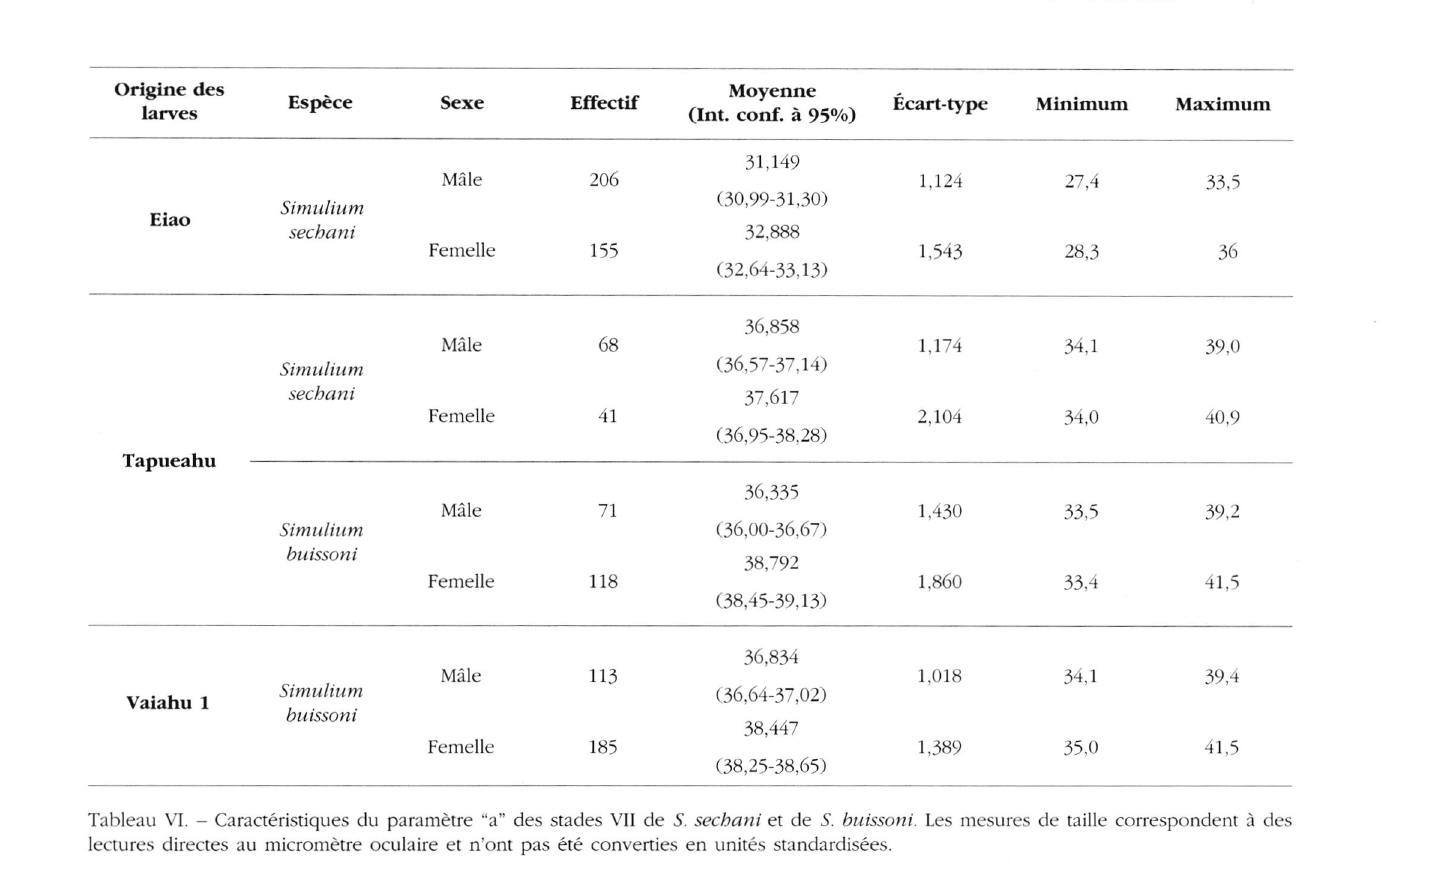
Origine des larves